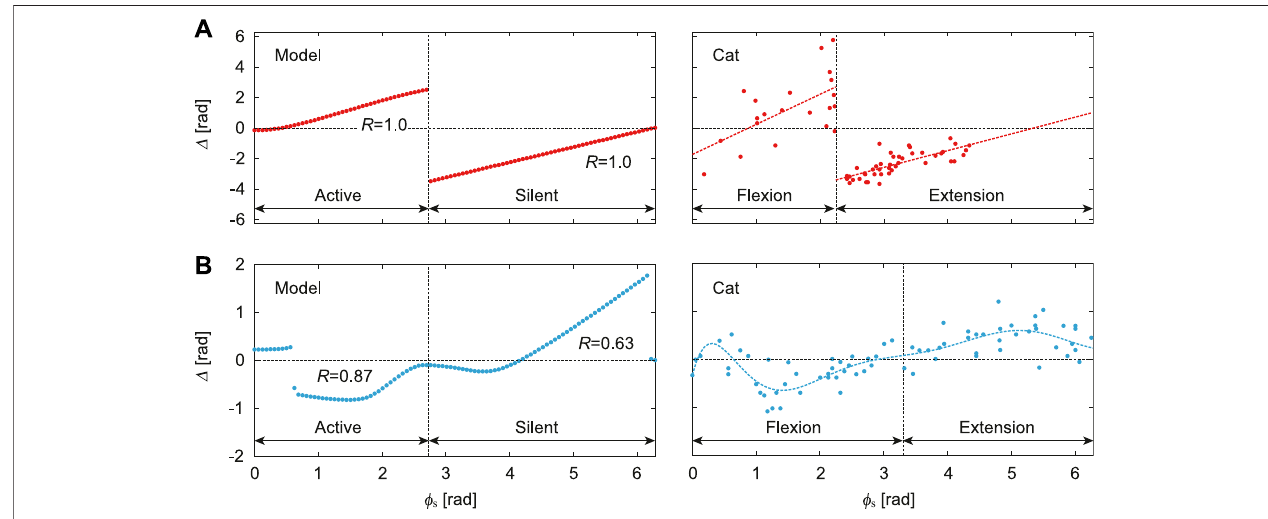
FIGURE 4 | Phase-dependent response of CPG model to a stimulation. (A) Response of PF-F neuron in our model to stimulation of the fl exor side compared with the response against fl exor muscle stimulation during fi ctive locomotion in spinal cats [adapted from Schomburg et al. (1998)], where the dotted lines are approximate functionsusinga fi rstorderpolynomialforeach fl exionandextensionphase. (B) ResponseofPF-Fneuronofourmodeltostimulationoftheextensorsidecomparedwith the response against extensor muscle stimulation during fi ctive locomotion in decerebrate cats [adapted from Duysens (1977)], where the dotted line is an approximate function using an eighth order polynomial. R is the correlation coef fi cient between the active/silent phase of the simulation results and fl exion/extension phase of the approximate